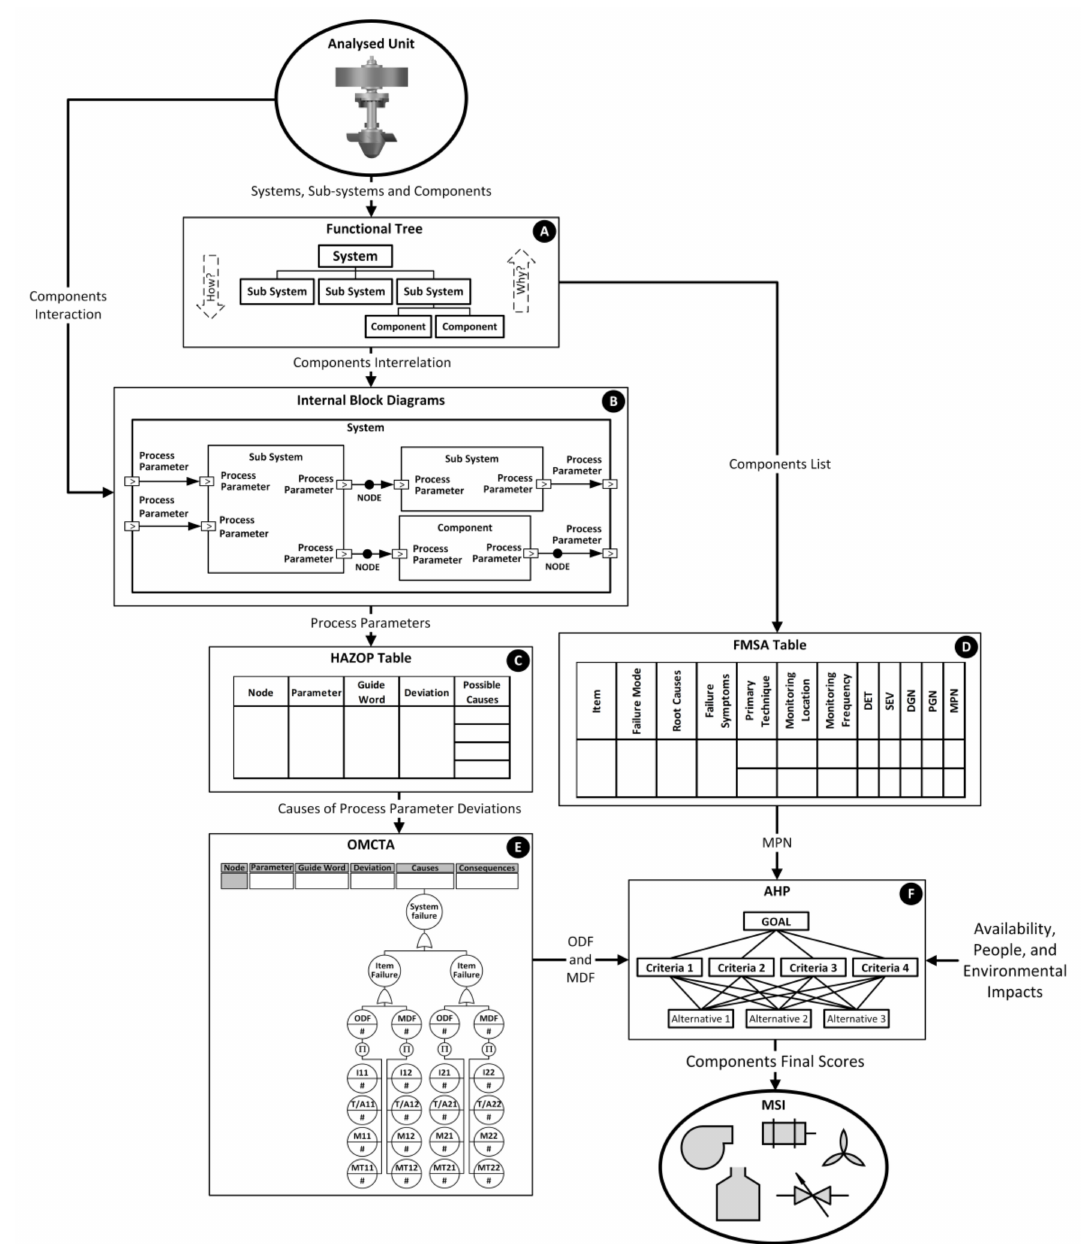
Figure 2. The proposed method illustrated flowchart with the presentation of each applied technique—( A ): Functional Tree (FT); ( B ): Internal Block Diagram (IBD); ( C ): Hazard and Operability Study (HAZOP); ( D ): Failure Mode Symptoms Analysis (FMSA); ( E ): Operation & Maintenance Tree Analysis (OMCTA); and ( F ): Analytic Hierarchy Process (AHP)—and the information flows between